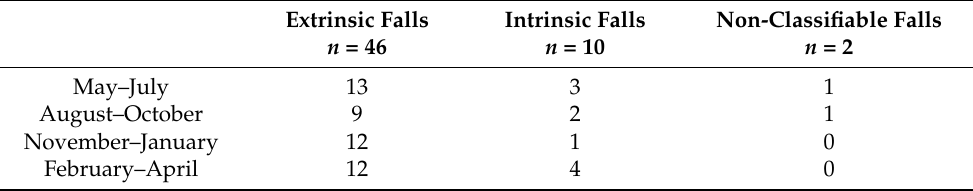
Table 2. Distribution of falls according to season and according to extrinsic/intrinsic falls.